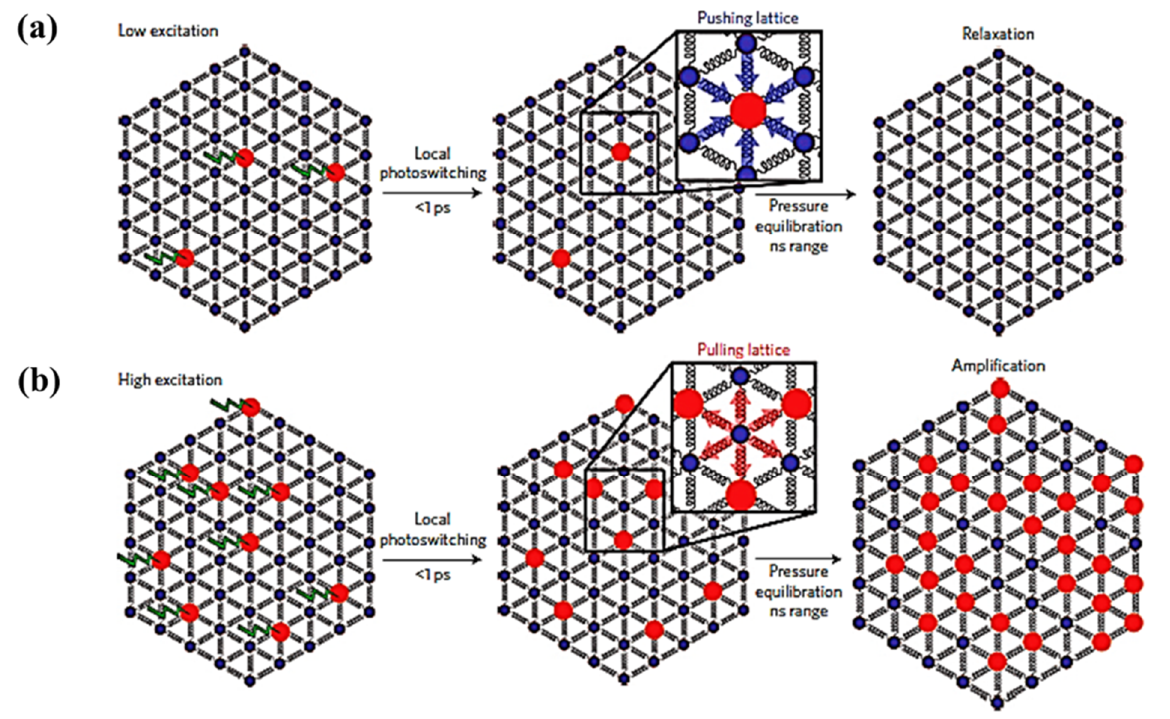
Figure 10. The schematic representation of the light induced cooperative phenomena, ( a ) At low excitation energy density only few molecules photo-switch to the high spin state and they can then relax back to low spin state under the pressure of low spin lattice, ( b ) At high excitation energy density more molecules will be photo switched to high spin which expands the volume of the lattice and it will pull more low spin molecules to high spin. Reprinted with permission from Ref. [59]. Copyright 2016 Springer Nature.